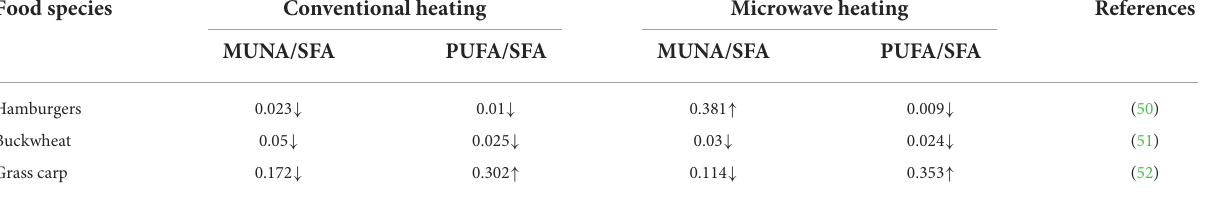
TABLE 4 Effect of microwave treatment on lipid composition in